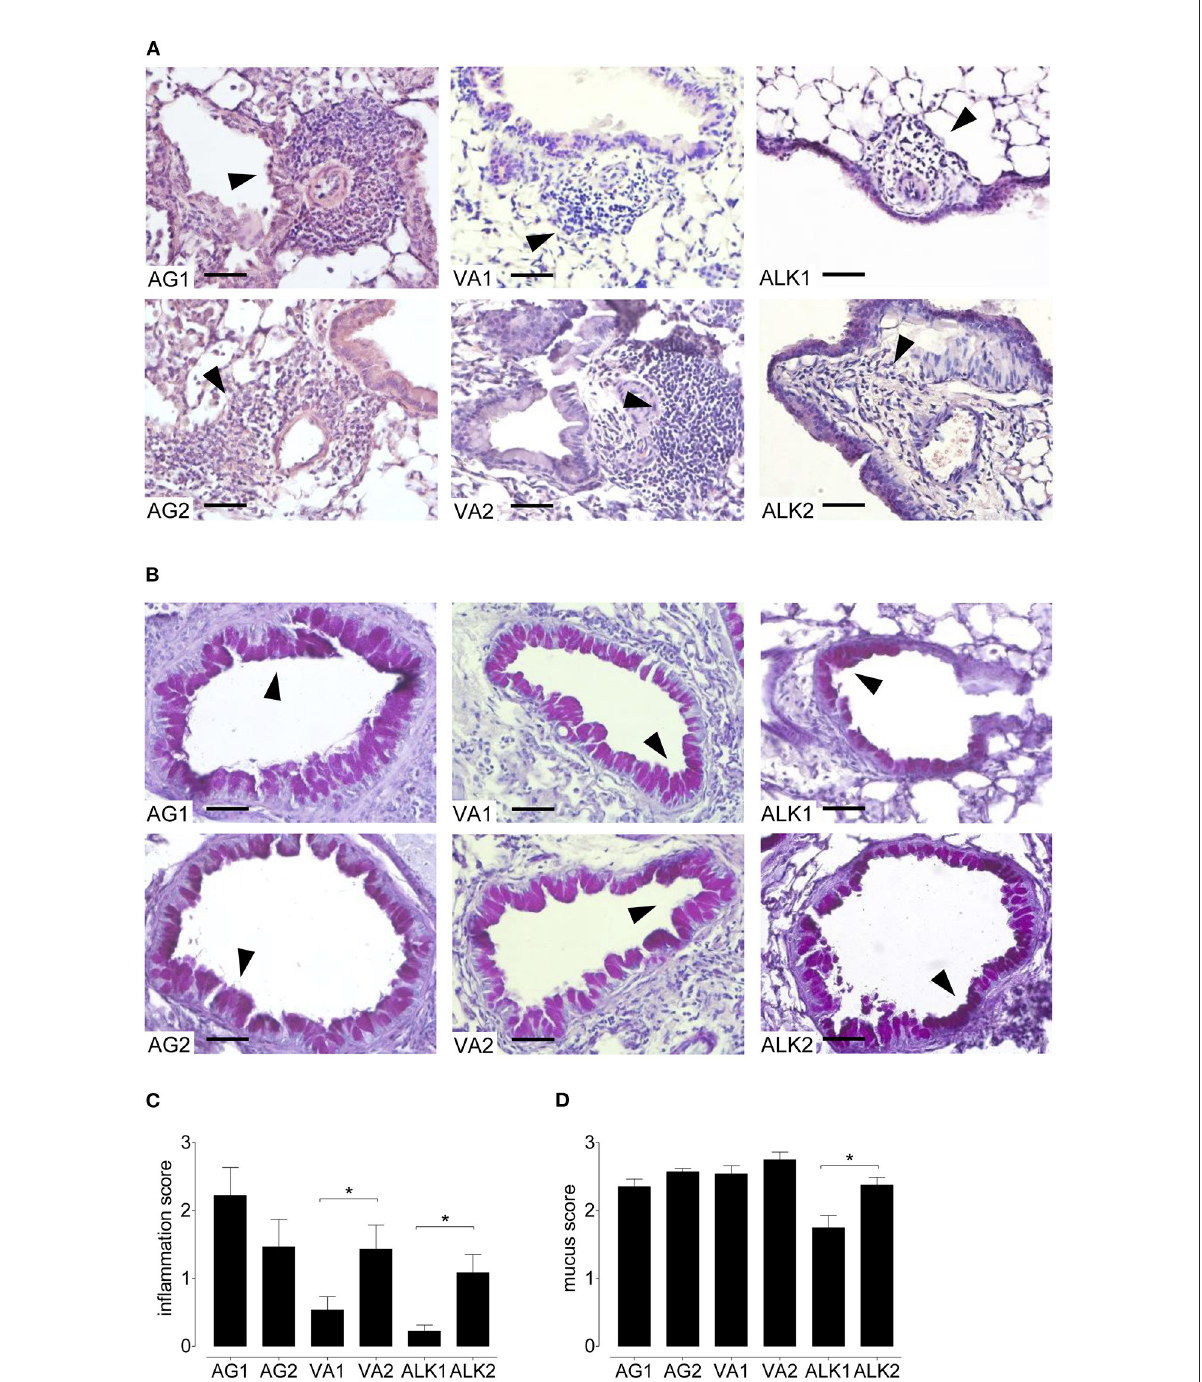
FIGURE5 Lung inflammation and mucus secretion during the onset of acute allergic disease with diverse RWP from different geographical locations. Representative photomicrographs of H & E- and PAS- stained lung tissue sections from 10 µ g per 50 µ l PBS RWP without added adjuvant over 21 days at a magnification of 400 × . (A) In H & E-sections, all RWP samples induced acute inflammatory infiltrates containing eosinophils (arrows), and (B) in PAS-stained lung tissue sections, all RWP samples had mucus in the goblet producing cells (arrows). Scale bars are 50 µ m. Graphs illustrate the quantification of the lung sections using a blinded semi-quantitative scoring system for lung inflammation (C) and mucus production (D) . Data are presented as mean ± SEM and are representative of at least two experiments; n = 8 . Asterisks indicate significant differences * p < 0.05 in the chi-square